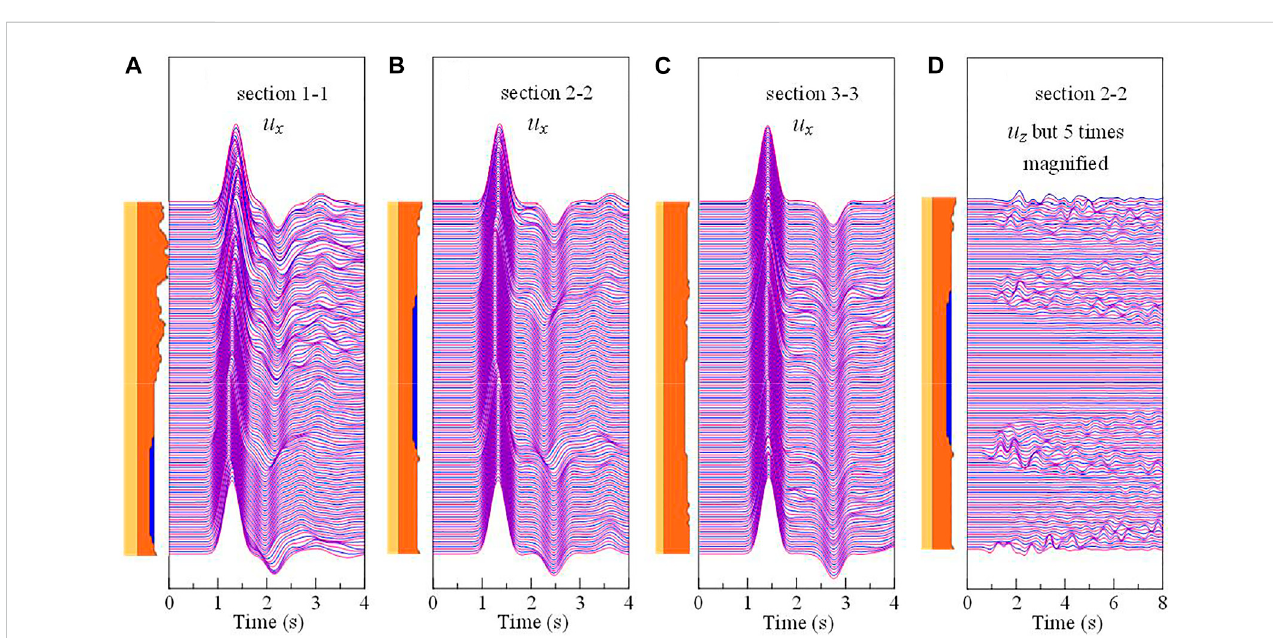
FIGURE 14 (A) Displacement waveforms in x-direction of section 1-1; (B) Displacement waveforms in x-direction of section 2-2; (C) Displacement waveforms in x- direction of section 3-3; (D) Displacement waveforms in z-direction of section